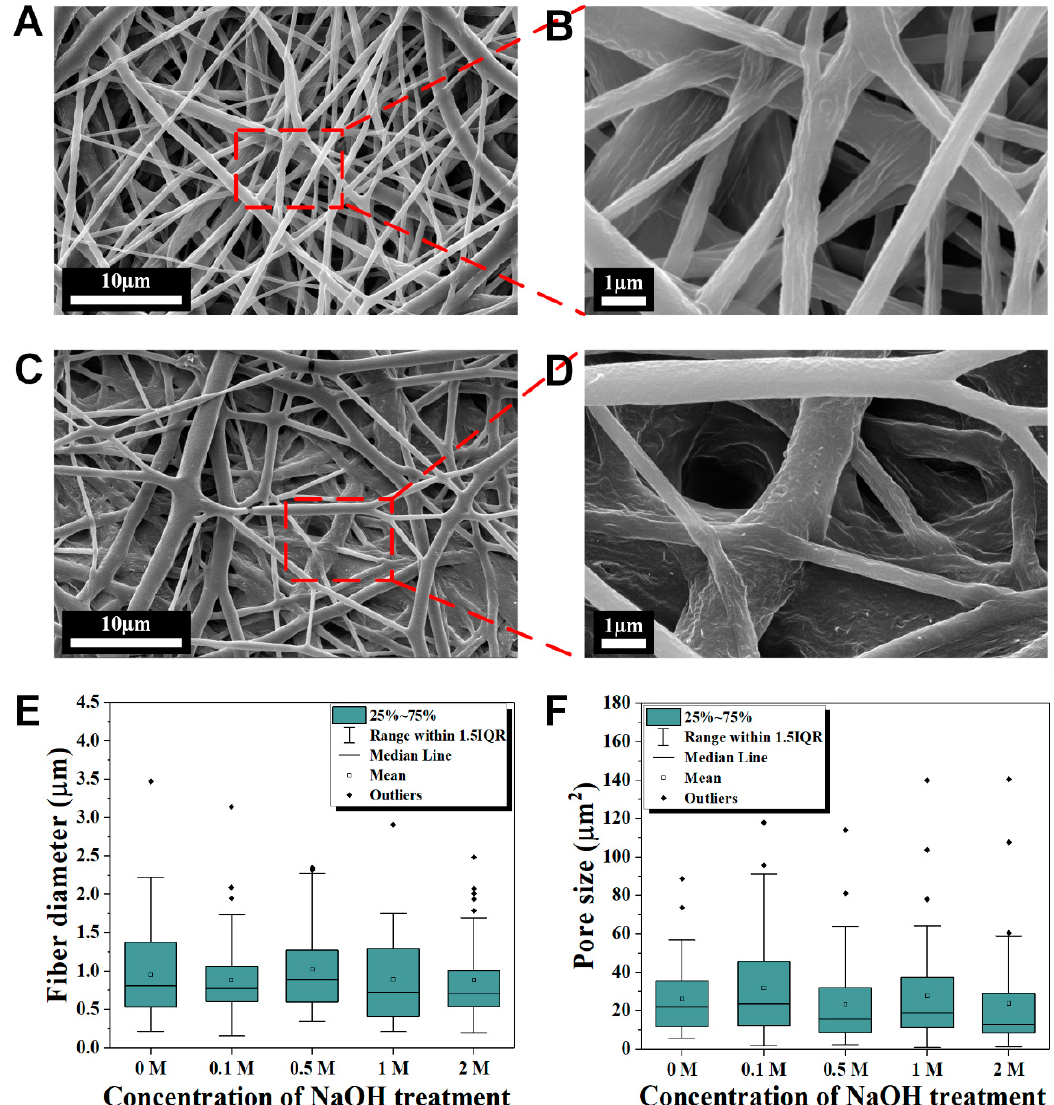
Figure 3. Surface morphology of PCL and hydrolyzed electrospun nanofibers. Compared to